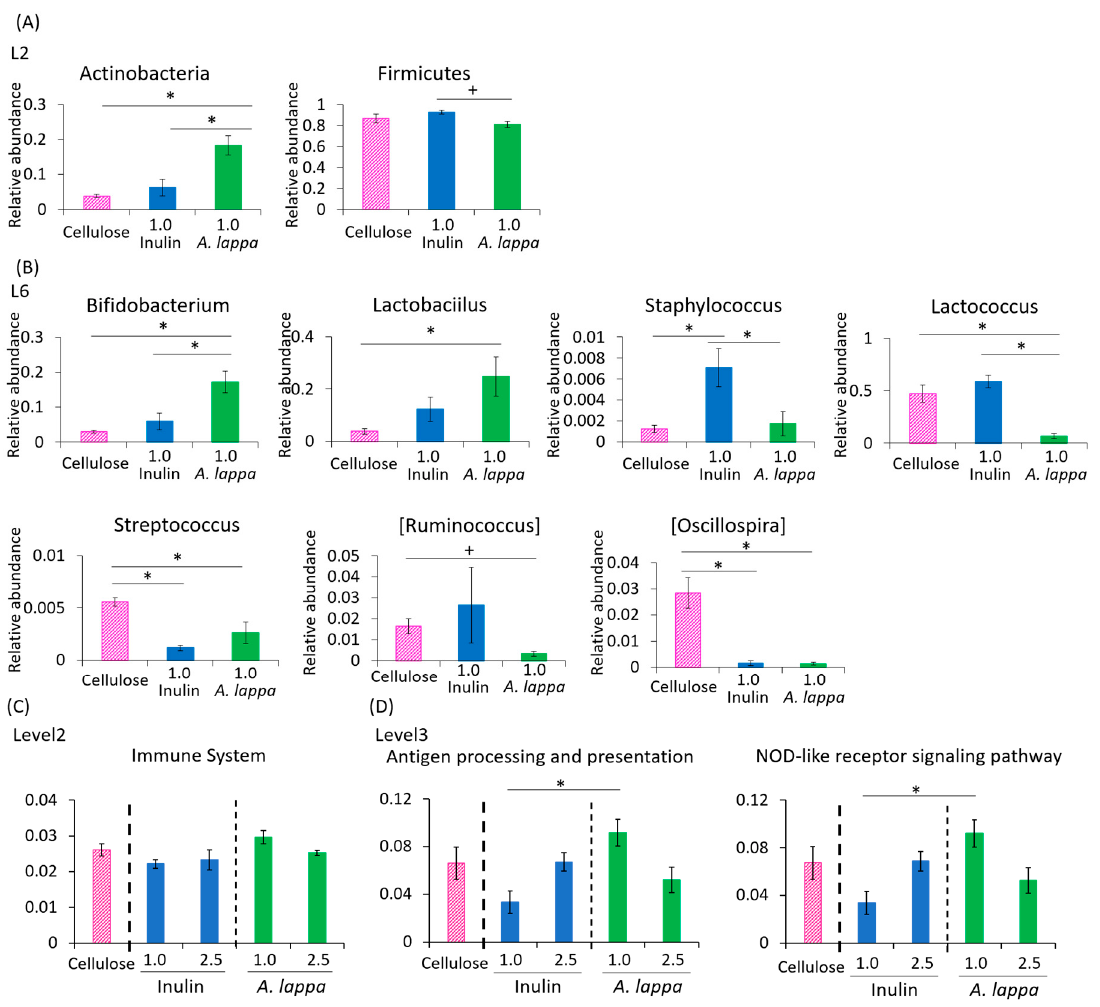
Figure 3. Effect of inulin or burdock on the relative abundance of some bacteria and prediction of function by PICRUSt analysis. ( A ) Relative abundance of phylum level, ( B ) genus level in each group, ( C ) PICRUSt analysis of immune system, and ( D ) antigen processing and presentation and the NOD-like receptor signaling pathway. All data are represented as mean ± SEM ( n = 5 for each group). * p < 0.05 evaluated using one-way ANOVA with Tukey’s post hoc test. + p < 0.05 evaluated using one-way ANOVA with Kruskal–Wallis test and Dunn’s post hoc test.